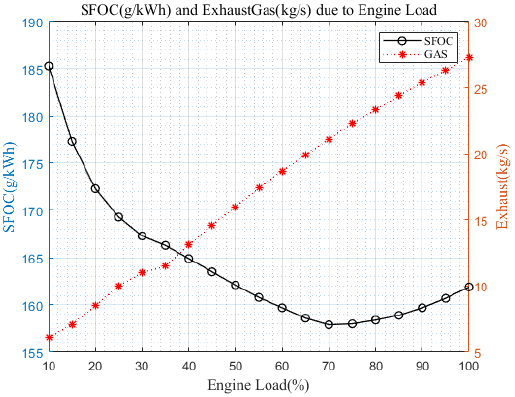
Figure 2. Fuel Oil Consumption estimation procedure (ISO 15016:2015 and Holtrop–Mennen method).